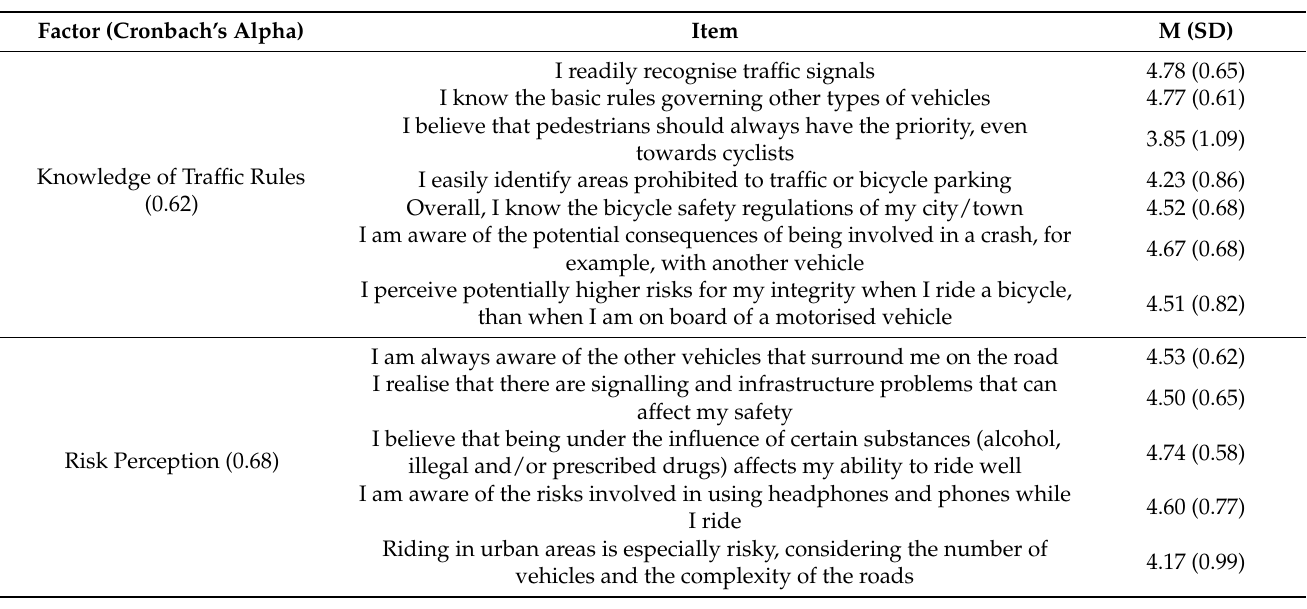
Table 2. Cyclists Risk Perception and Regulation Scale (RPRS) item scores (scale